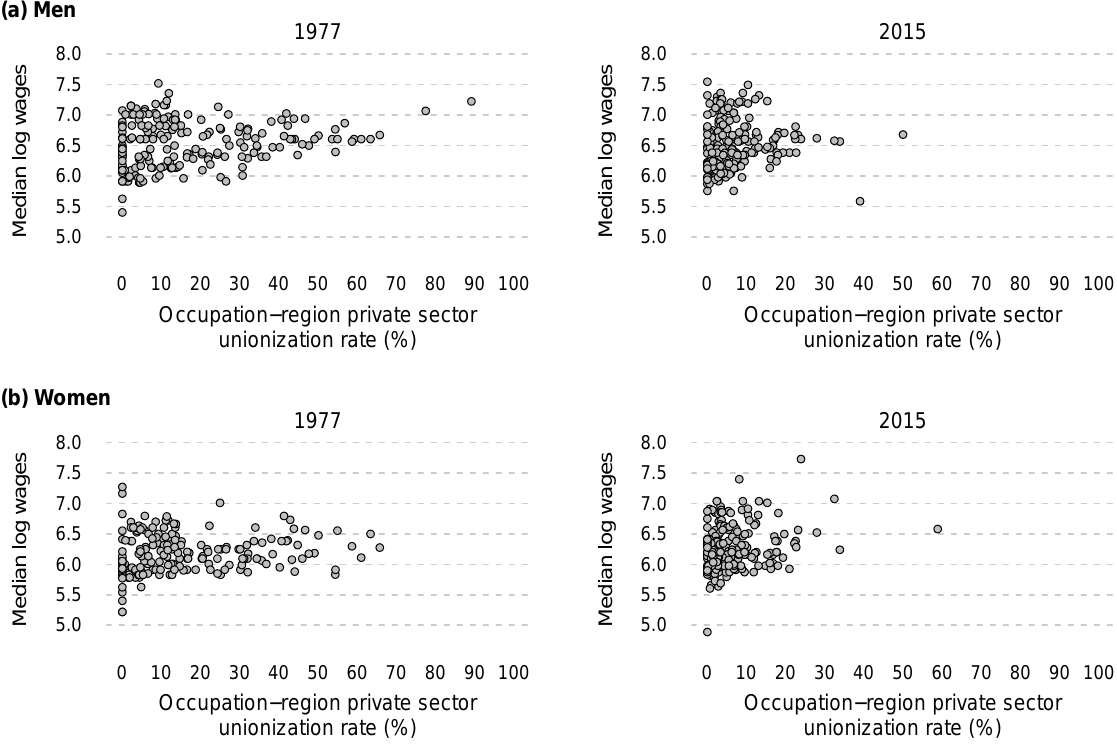
Figure 2: Occupation region unionization rate and nonunion median log weekly wages. region education effect? Though the occupation region and individual education measures are correlated, the average education level of an occupation can increase occupational rewards independently of an individual’s own education. Whether educational credentials represent actual skills required to carry out the tasks of a particular occupation or function as a signal with cultural relevance, Weeden (2002:Table 4) demonstrates that they represent an important source of occupational closure and that higher average educational levels are related to higher